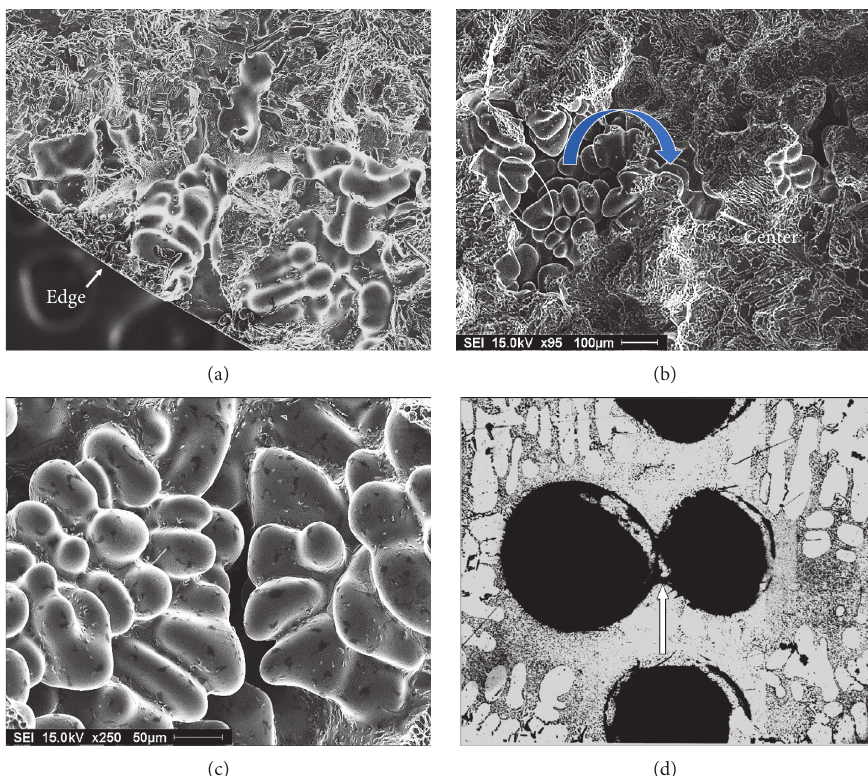
Figure 8: Fracture surface of fatigue tested samples: (a) presence of disconnected pores at the sample surface, (b) shrinkage porosity at the center of the samples, (c) high magnification micrographs of the dendrites in (b), (d) joining of pores during loading-loading axis is normal to the polished